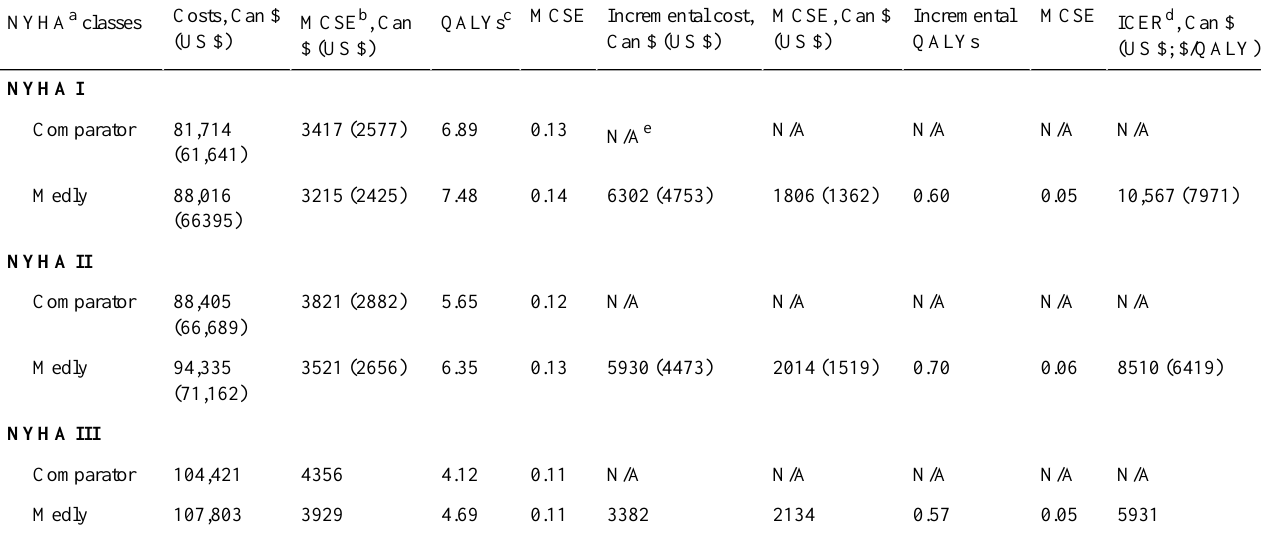
Table 6. Deterministic results for New York Health Association classes I, II, and III.